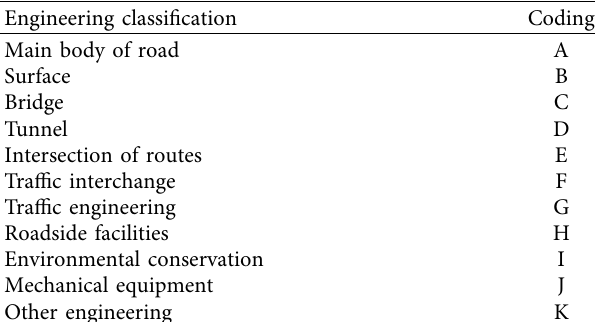
Table 2: Rules of the 4 th district EBS